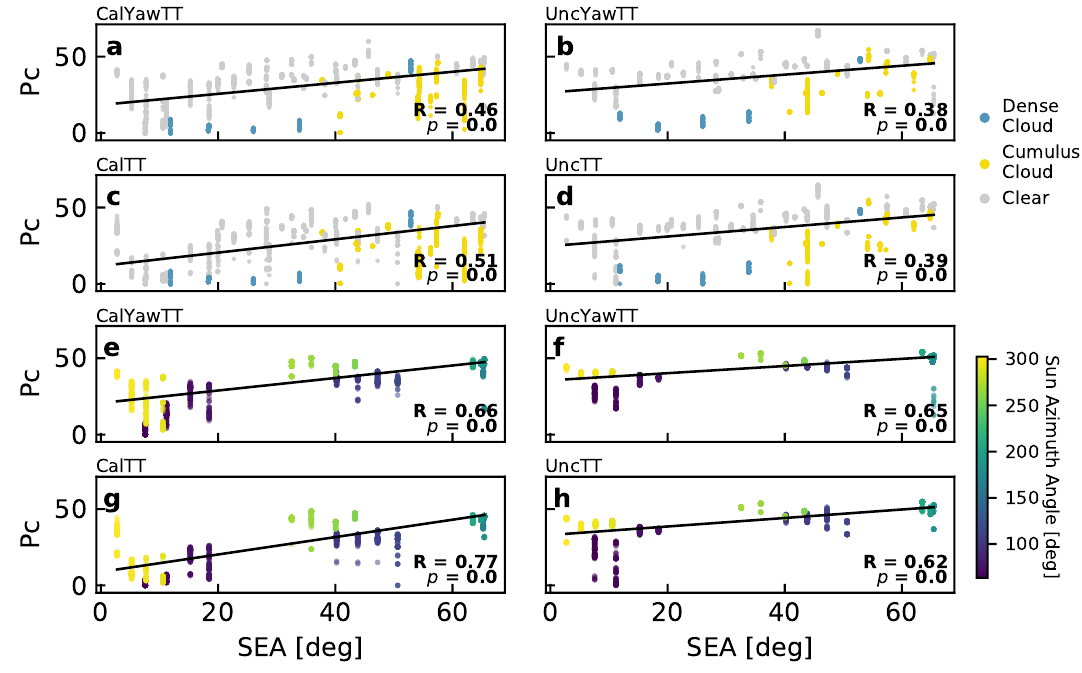
Figure 5. Pc per sun elevation angle (SEA) and weather conditions for ( a ) CalYawTT, ( b ) CalTT, ( c ) UncYawTT, and ( d ) UncTT and PC per SEA at clear sky conditions over same areas during one day for ( e ) CalYawTT, ( f ) CalTT, ( g ) UncYawTT, and ( h ) UncTT.